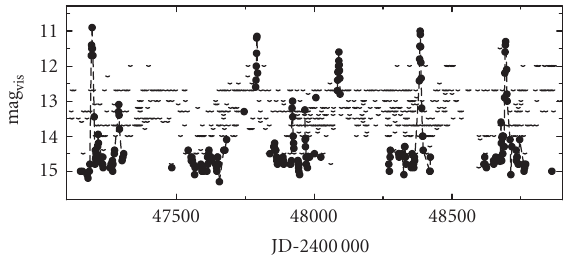
Figure 3: (a) Part of the light curve of the dwarf nova CH UMa showing the bright and faint outbursts (AFOEV data). Closed circles denote detections. Upper limits are marked by ∨ . Adapted from